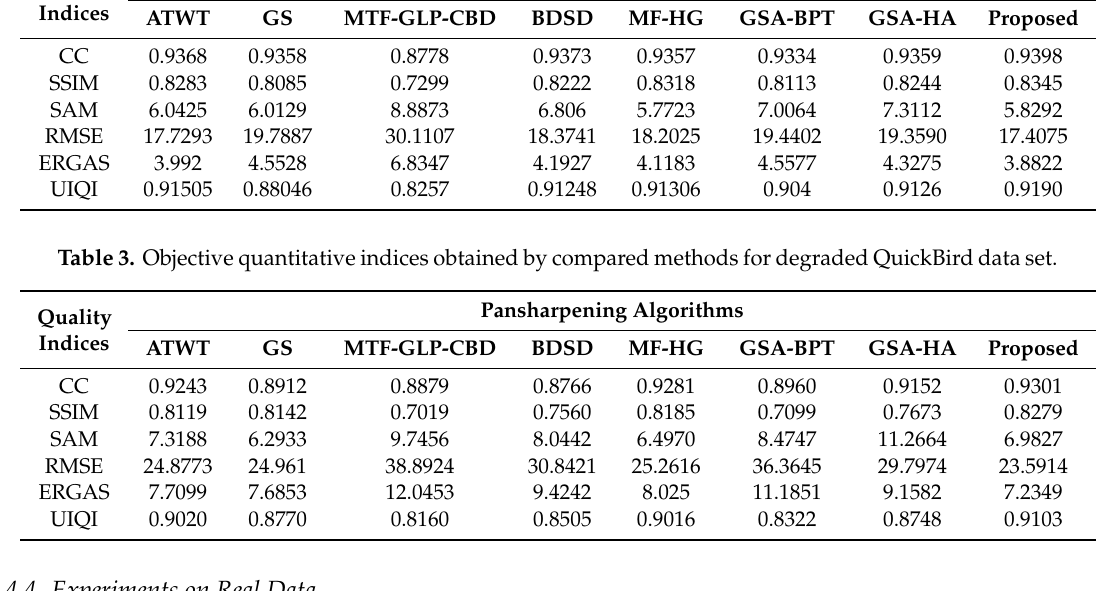
Figure 8. Fusion results of degraded data set from the QuickBird satellite: ( a ) reference image; ( b ) ATWT; ( c ) GS; (d) MTF-GLP-CBD; ( e ) BDSD; ( f ) MF-HG; ( g ) GSA-BPT; ( h ) GSA-HA; and ( i ) proposed method. Table 2. Objective quantitative indices obtained by compared methods for degraded GeoEye-1 data set. Quality